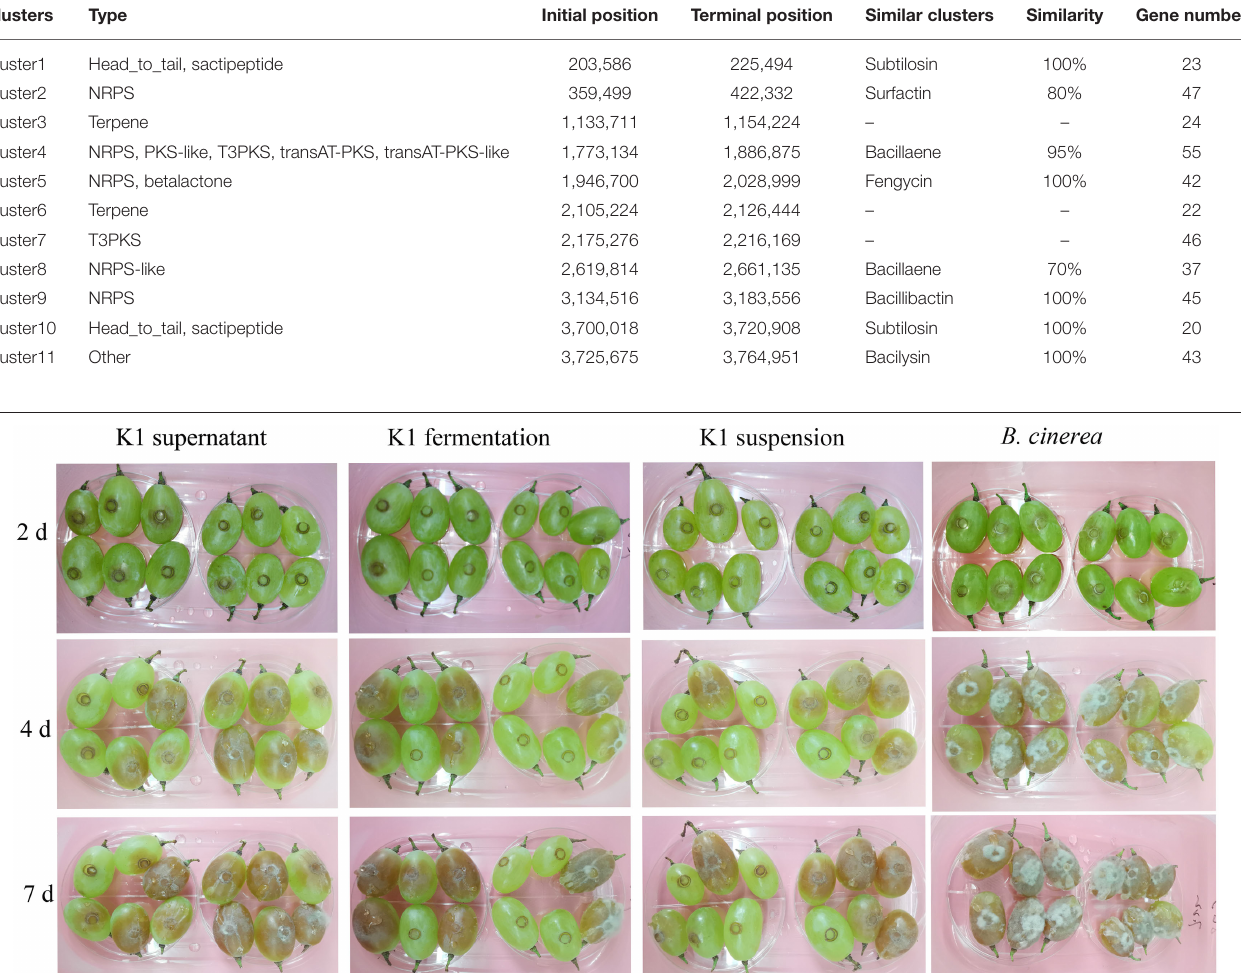
TABLE 1 | Predicted gene clusters of biosynthesis in Bacillus K1.